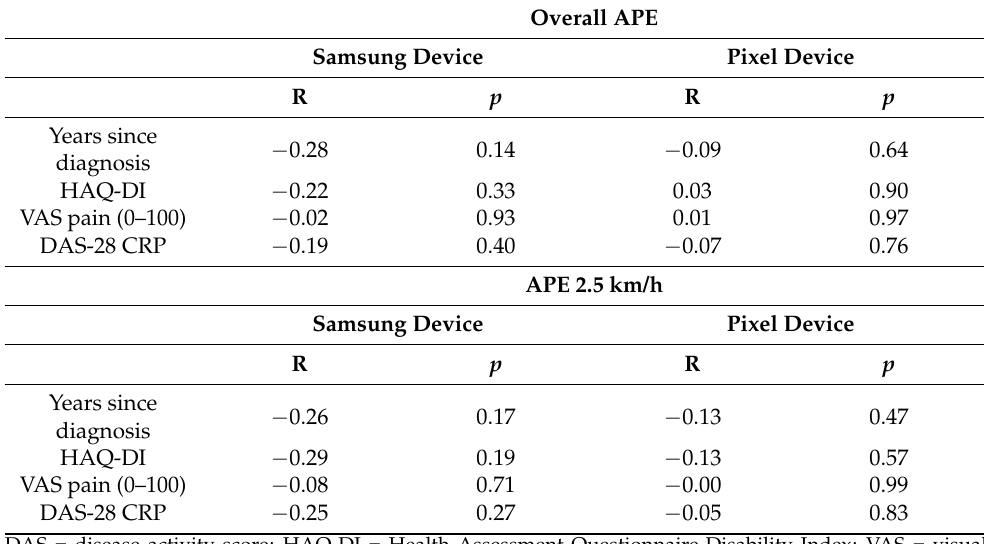
Table 4. Spearman’s rank correlation between APE and continuous clinical variables.